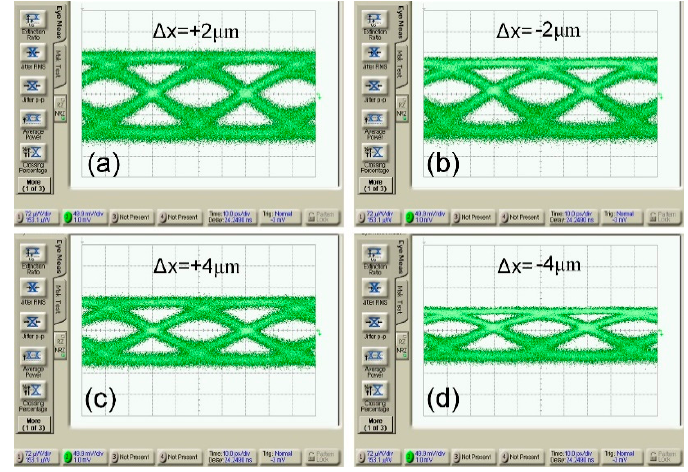
Figure 10. 25 Gb/s eye diagram of WDM transmitter at different fiber offset from the central position of the grating coupler along the horizontal direction of waveguide: ( a ) +2 μ m offset, ( b ) − 2 μ m offset, ( c ) +4 μ m offset, ( d ) − 4 μ m offset.